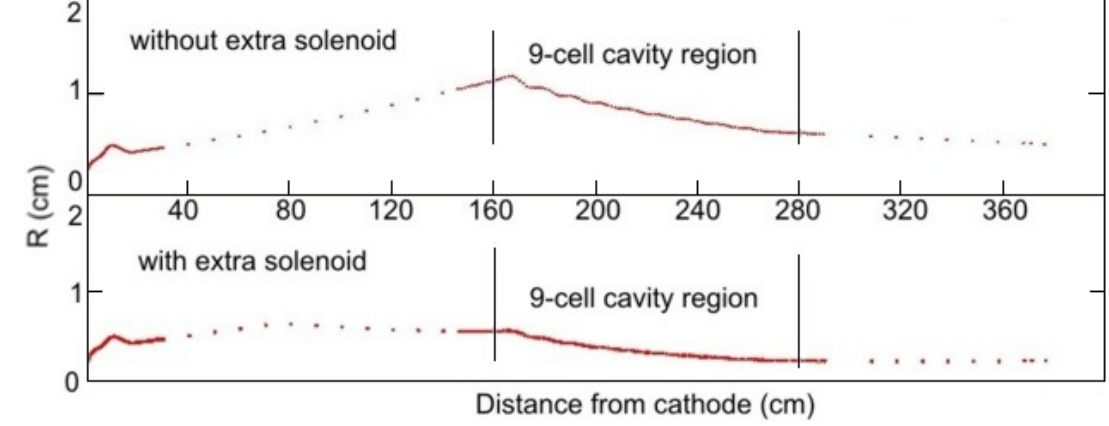
FIG. 5. (Color) Bunch radial profile for nonlinear